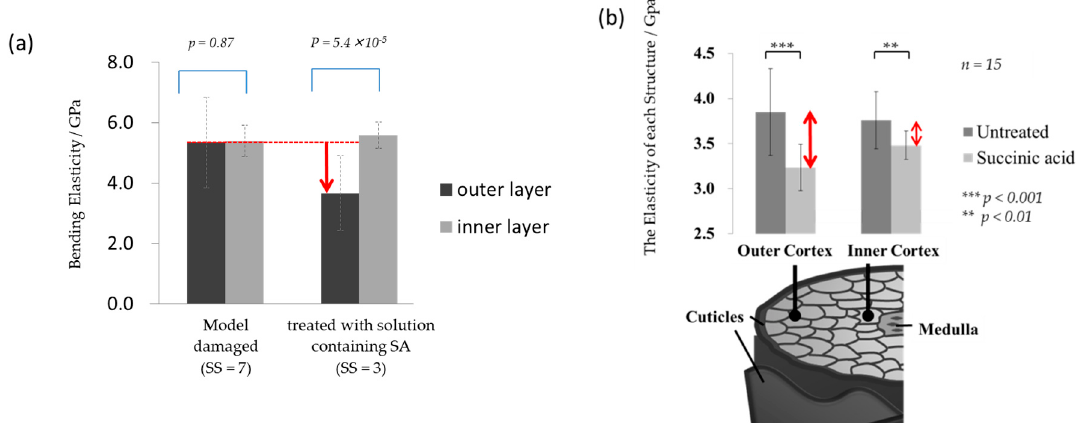
Figure 8. The difference in mechanical properties of model damaged hair and hair treated with a solution containing succinic acid (SA) [18]. ( a ) Bending elasticity, Measurements at 20°C and 65% relative humidity (RH), n = 20, SS = sensory score ( b ) elasticity of each structure measured using atomic force microscopy (AFM).